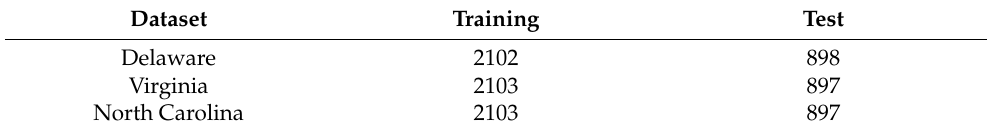
Table 3. Initial training and test set split